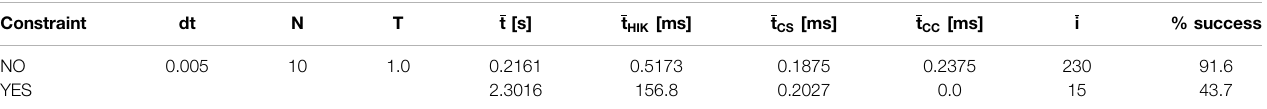
TABLE4| Comparisonbetweentheresultsobtainedwhengeneratingcon fi gurationswiththeNSPGwithandwithoutthecollisionavoidanceconstraint.Inthe fi rstcase,the random velocity vector is generated and updated depending only on the static stability of the robot. The table contains the same parameters as in Table 3 . Constraint